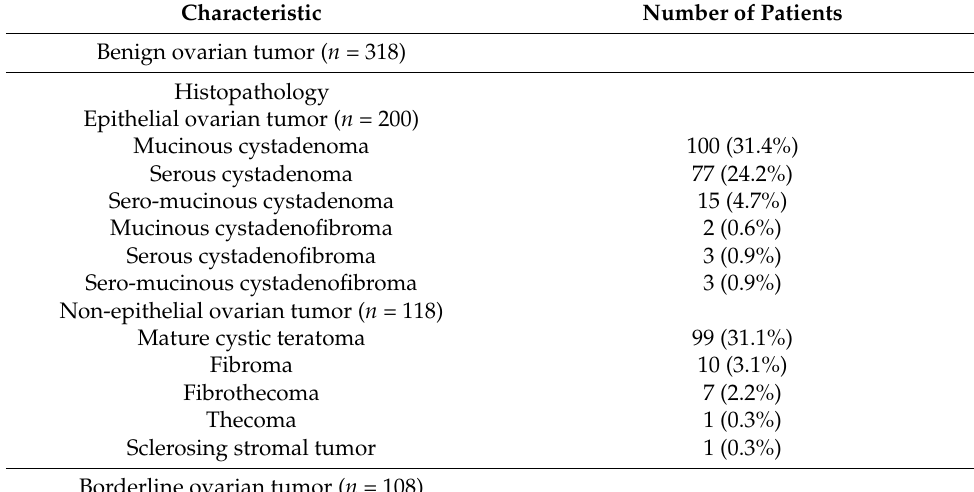
Table 1. Histopathology and characteristics of the enrolled patients with ovarian tumor.